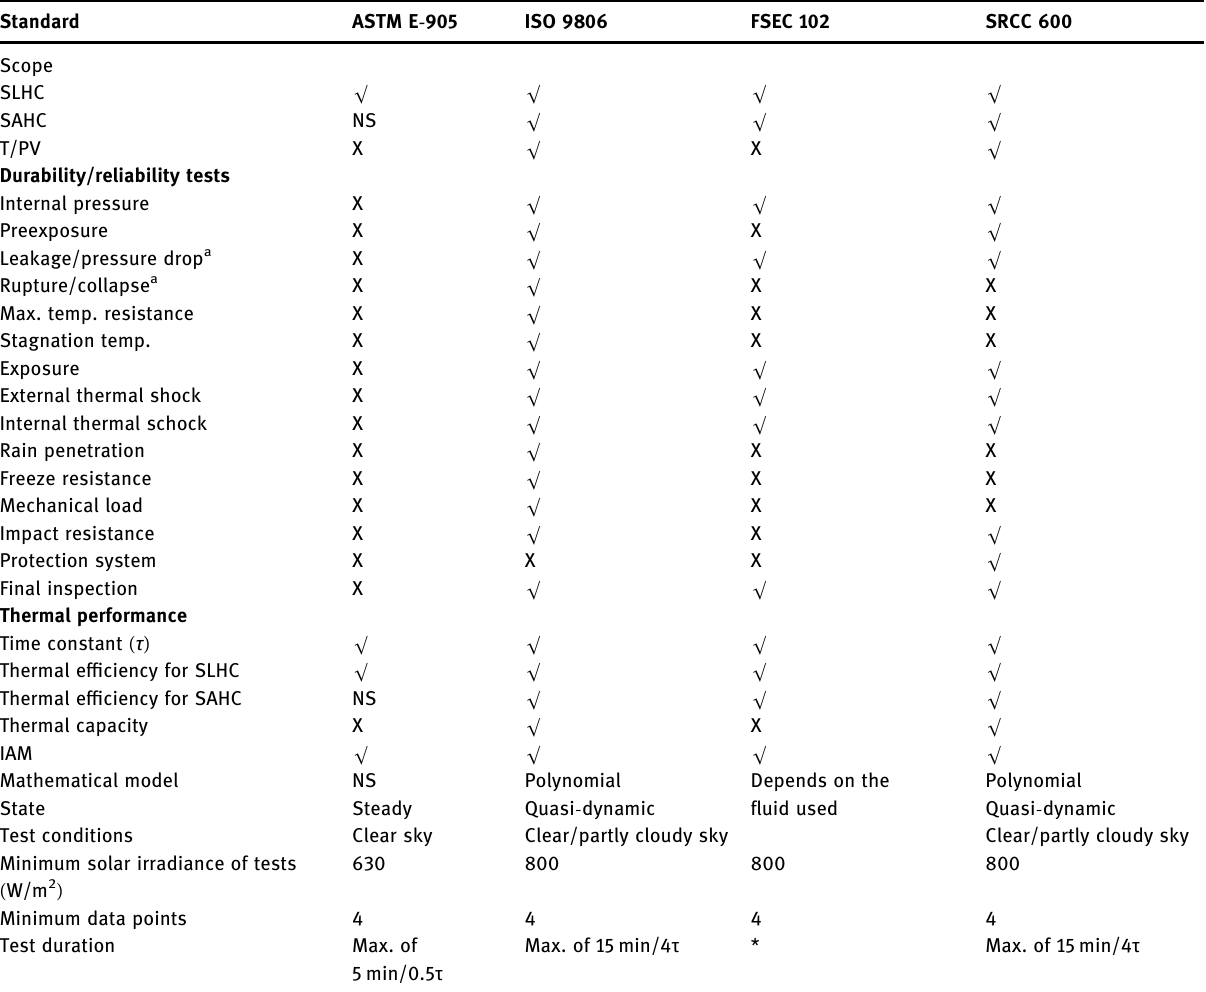
Table 20: Reliability and performance tests included in each standard [ 222 – 224,227 ]